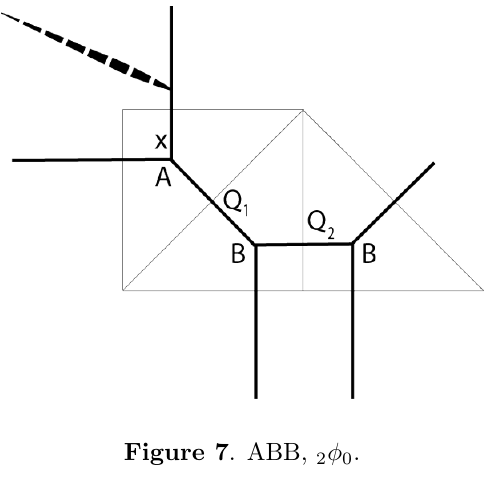
Figure 7 . ABB, 2 (cid:30) 0